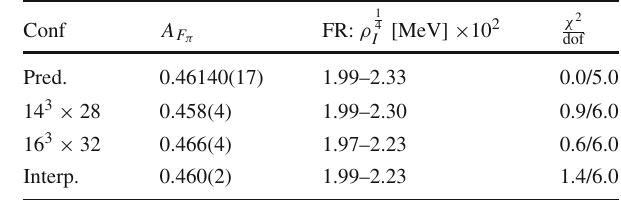
Table 22 Comparisons of the fitting results of the slope A m π obtained Table 23 Comparisons of the fitting results of the slope A F π